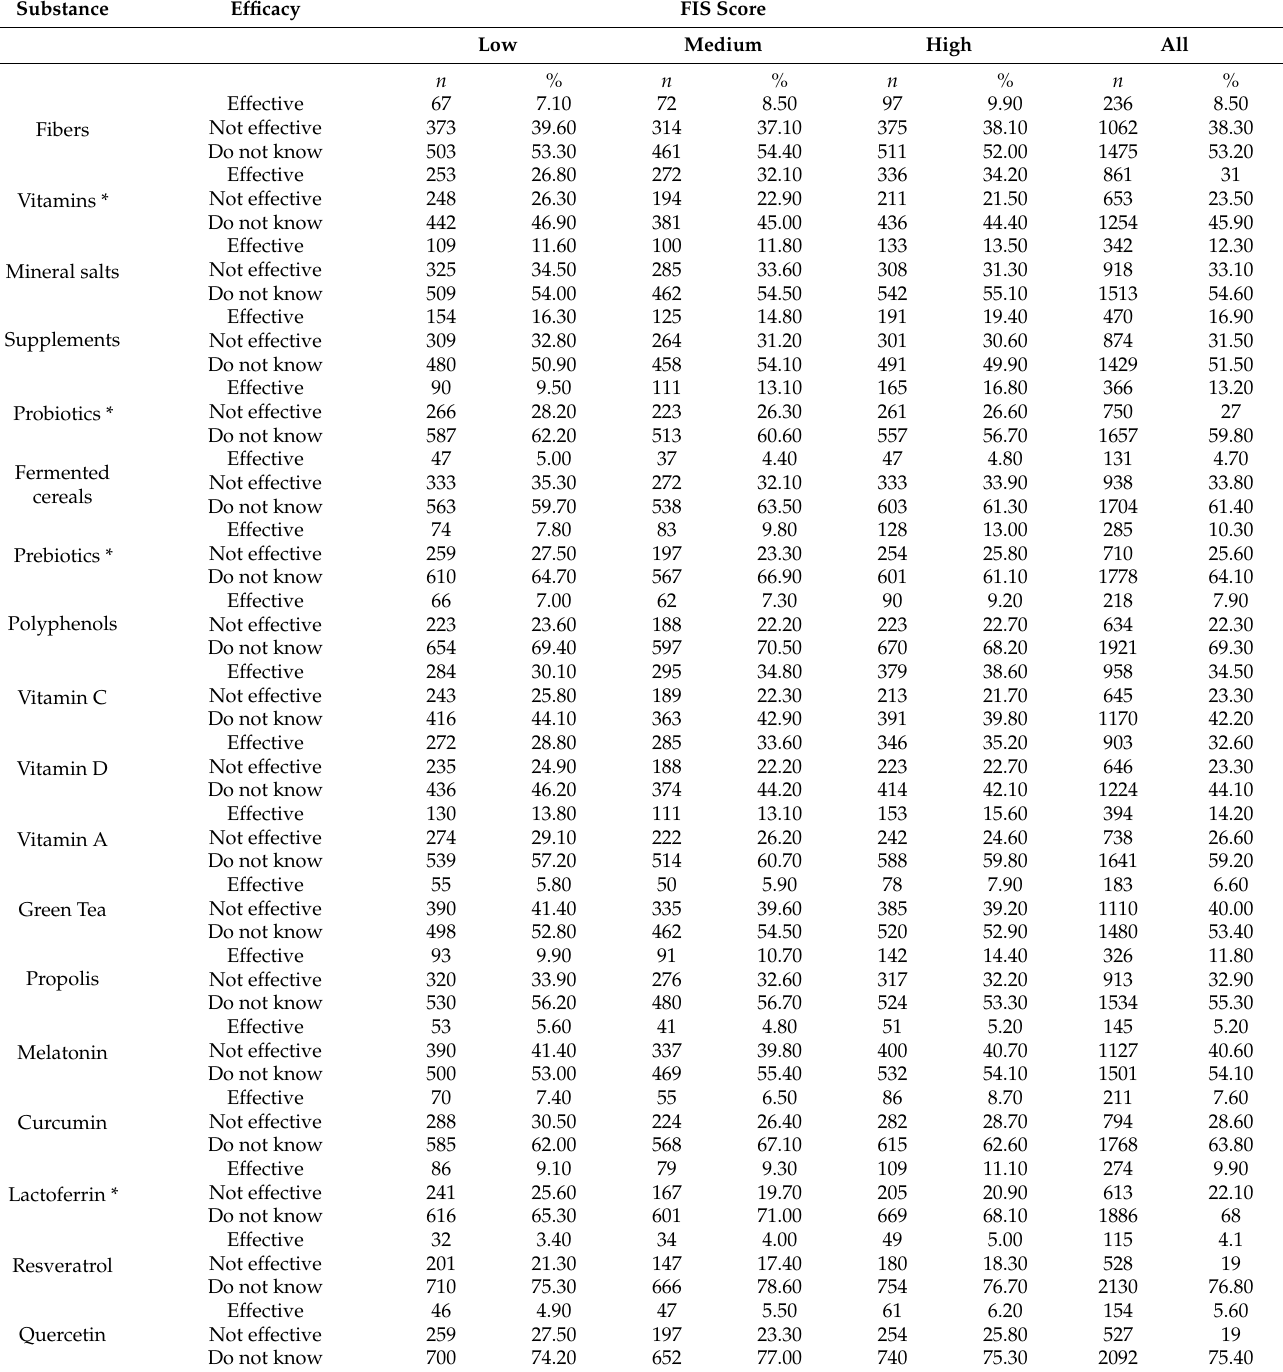
Table 8. Contingency tables used to summarize the relationship between bioactive compounds’ efficacy against COVID-19, according to FIS